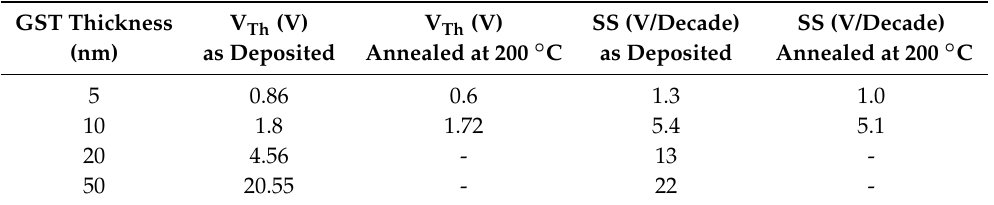
Table 1. Threshold voltages (V Th ) and subthreshold swings (SS) of the GST TFTs extracted at a drain-source voltage V DS = − 100 mV. GST Thickness V Th (V) V Th (V) as Deposited Annealed at 200 ◦ C as